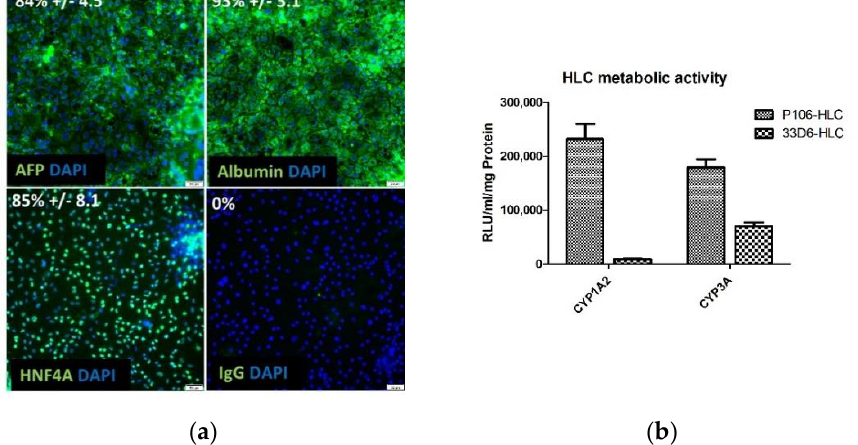
Figure 1. Characterisation of induced pluripotent stem cell (iPSC)-derived hepatocyte-like cells (HLCs) on d20 of differentiation. ( a ) Fixed cells (P106-HLCs) were stained for albumin, AFP, and HNF4α to assess hepatic characteristics and maturation state of HLCs. Immunofluorescence staining (40x magnification) shows that d20 HLCs co-express albumin and AFP representing mature and fetal characteristics (five fields of view per well with 400 cells, three wells per condition). ( b ) Metabolic activity. The metabolic activity of P106- and 33D6-HLCs was determined by measuring the activity of cytochrome P450 (CYP)1A2 and CYP3A in HLCs. CYP-activity was measured in RLU and normalised to ml and mg of total protein ( N = 4). d20 HLCs are metabolically active, showing successful di ff erentiation. P106-HLCs show improved metabolic activity compared with 33D6-HLCs. Results are shown as mean +/ − SEM. AFP = alpha fetoprotein, DAPI = 4′,6 -Diamidin-2-phenylindol, HNF4α = hepatocyte nuclear factor 4 alpha, RLU = relative light units .